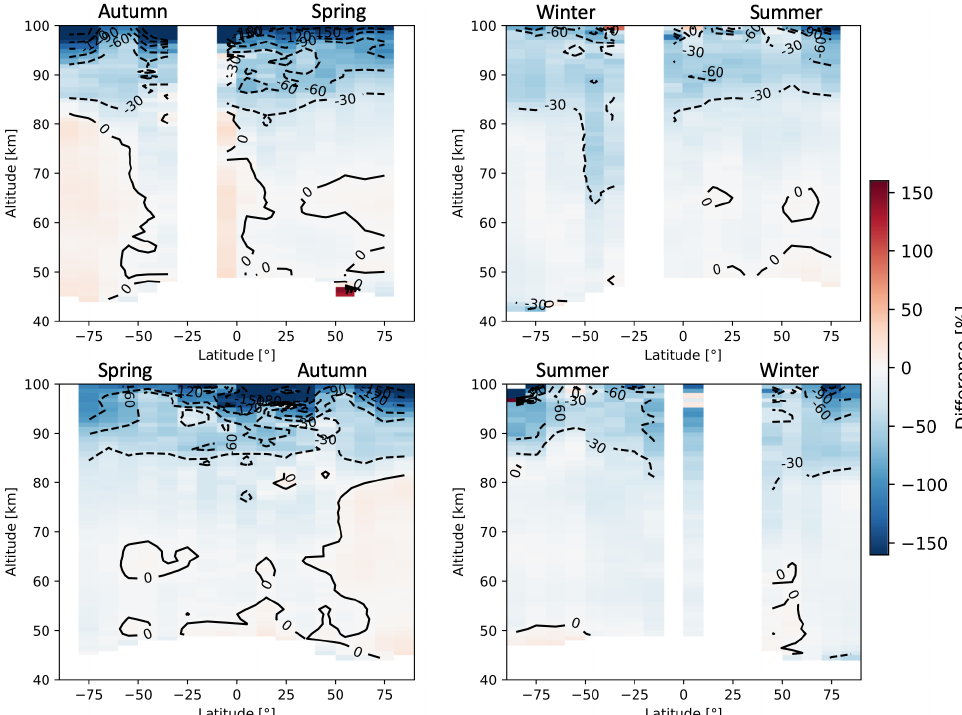
Figure A16. Seasonal zonal means of H 2 O FM13 SMR–ACE relative differences averaged over the time period between February 2004 and April 2019. The seasons are intended as astronomical seasons, i.e. each starting at the respective solstice or equinox.